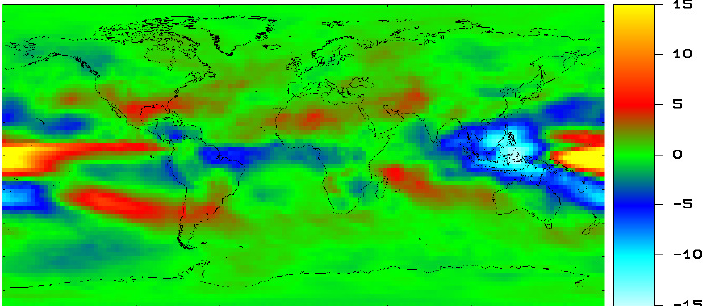
Figure 7. Change of HIRS OLR between El Niño years and La Niña years. The scale is in W/m 2